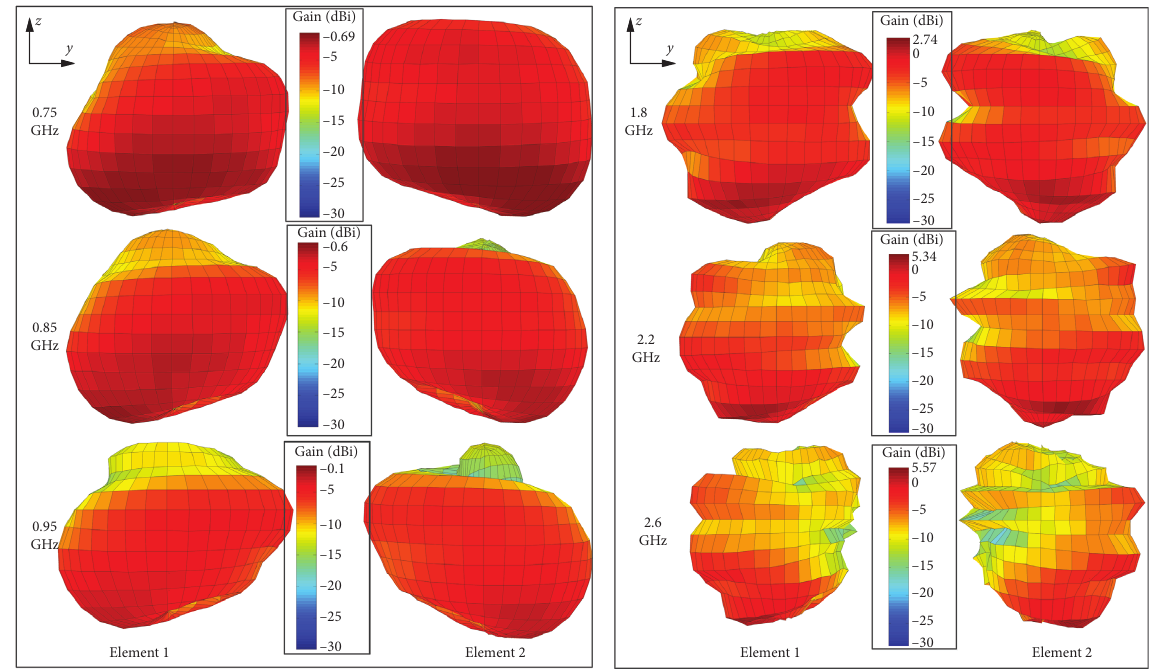
Figure 11: Measured 3D radiation patterns of the proposed antenna.